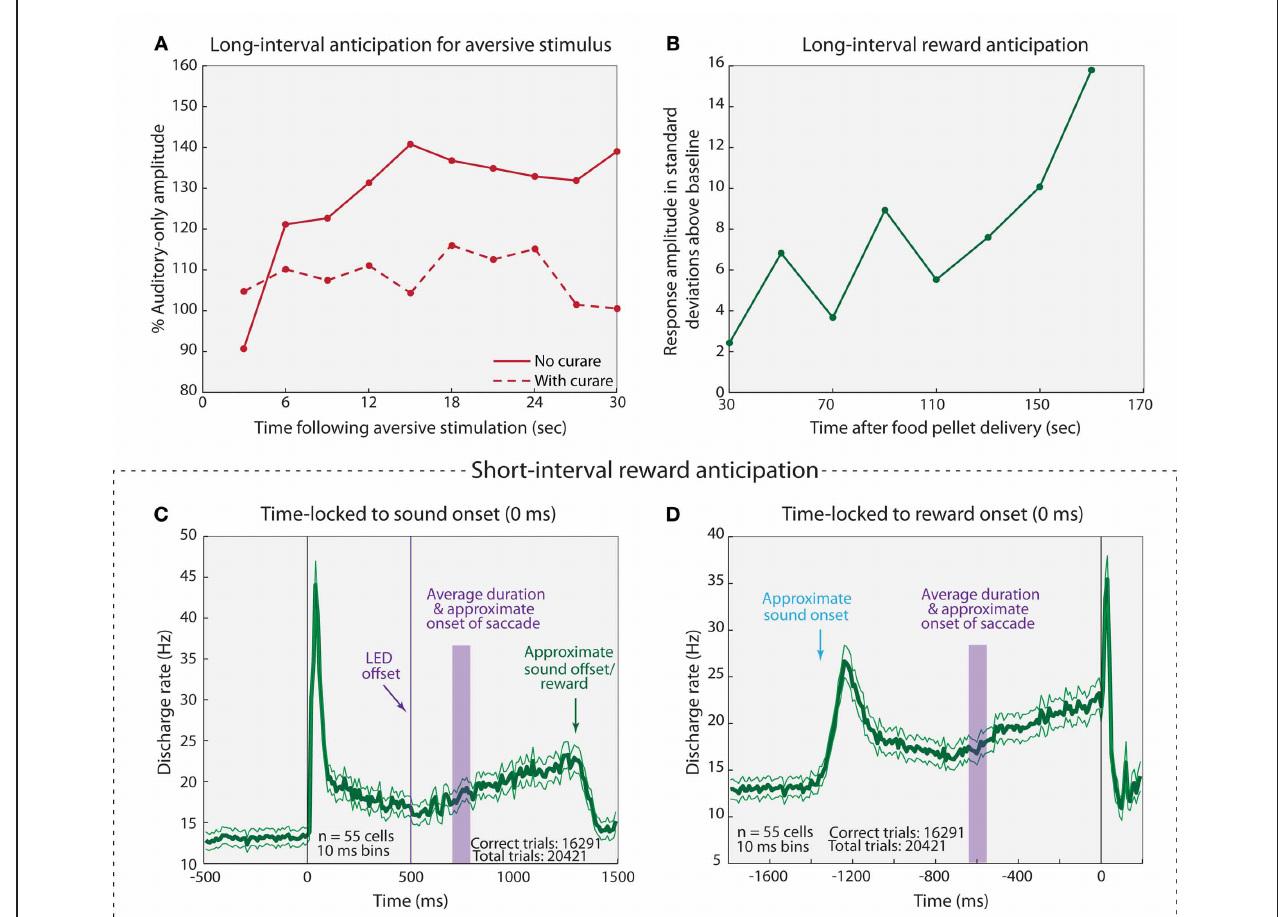
FIGURE 6 | Anticipatory responses of IC cells. (A) Average-evoked potential recorded from the IC in response to sounds presented at 3s intervals following aversive stimulation of the mesencephalic central gray (MCG) with (dashed line) and without (solid line) curare. MCG stimulation occurred at a fixed interval of 30s (thus, 0s post-MCG stimulation may be thought of as 30s pre-MCG stimulation for the following trial). (B) Representative example of a multi-unit response to sound presentation following rewarding stimulus. Sounds were played at varying intervals (up to 180s) following reward, and the next reward was delivered after a second variable interval. Note that no error bars were provided in the